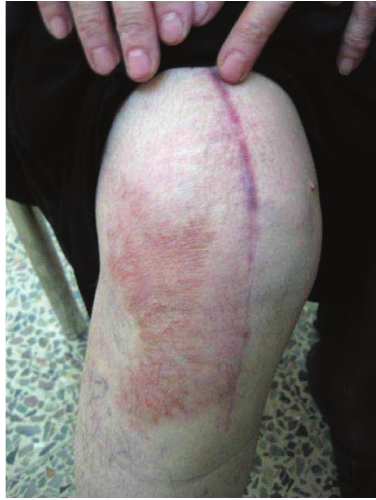
Figure 2: A slightly scaly erythematous plaque on the front of the right knee joint, on the lateral side of the incisional scar